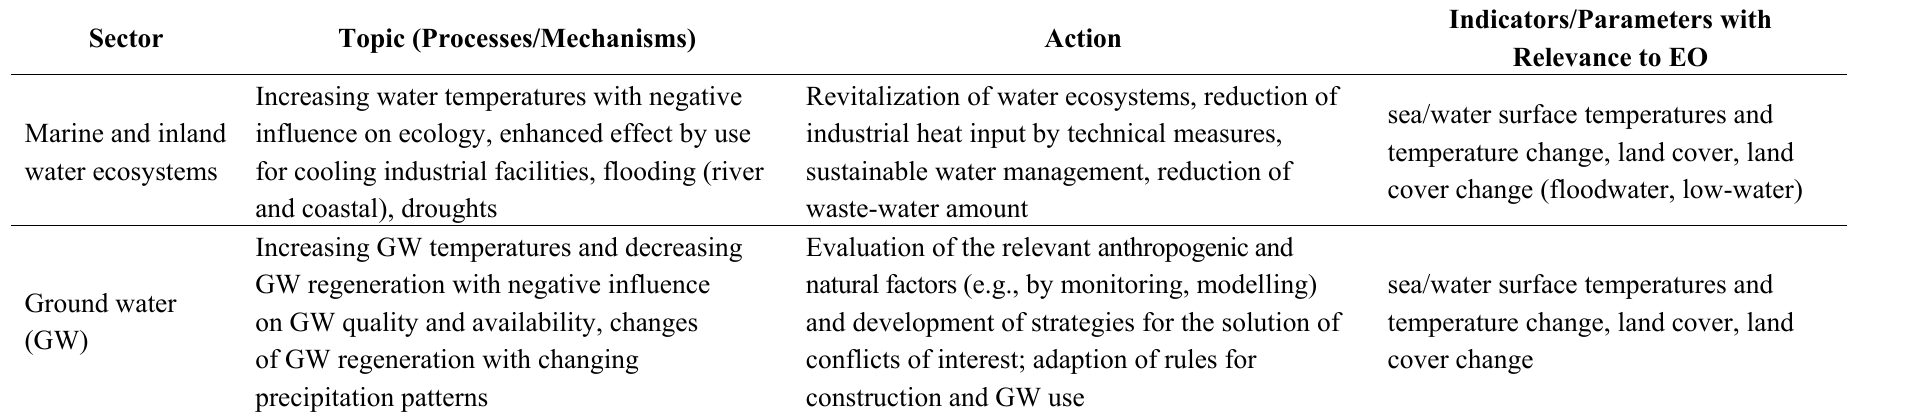
Table 2. Requirements for adaptation to climate change and the associated indicators with relevance to EO